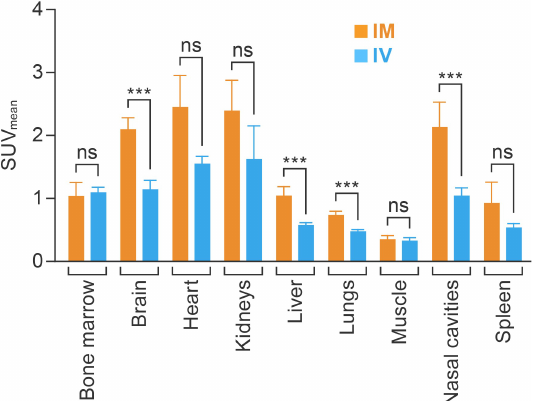
Figure 4. Comparing the average SUV mean for major organs and areas at 60 min after IM (n = 5) and IV (n = 3) injection. Each column represents the group average per administration route. The value in each cell represents the average SUV mean . SUV mean , mean standardized uptake value; IM, intramuscular; IV, intravenous; ns, not significant; ***, p <